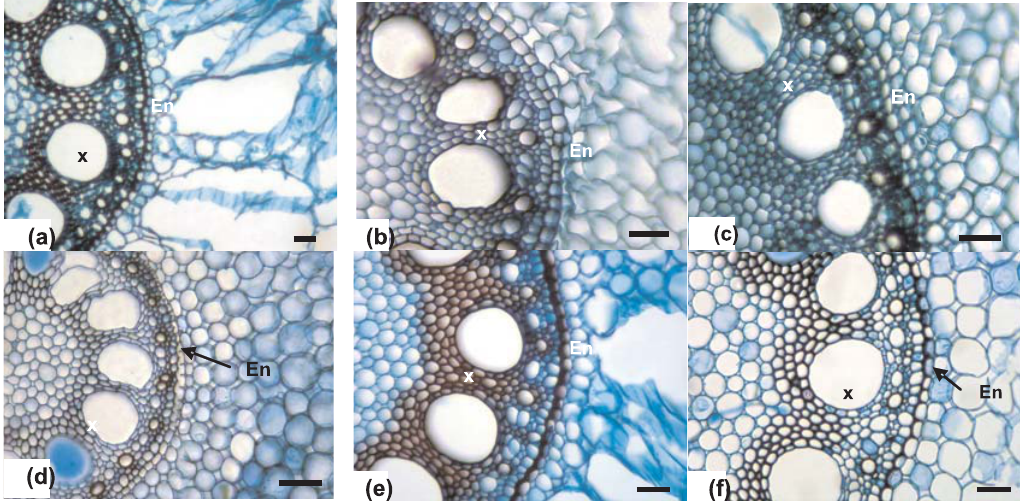
Figura 6. Alterações estruturais na raiz de milho cultivada em solo com Cd e Zn, sem calagem (a) a (c) e com calagem (d) a (f). Raízes do tratamento-controle (a) e (d), (b) e (e) raízes expostas a 20 mg kg -1 de Cd e (c) e (f) a 150 mg kg -1 de Zn. x: xilema; En: endoderme. Barras: 50 (cid:122)